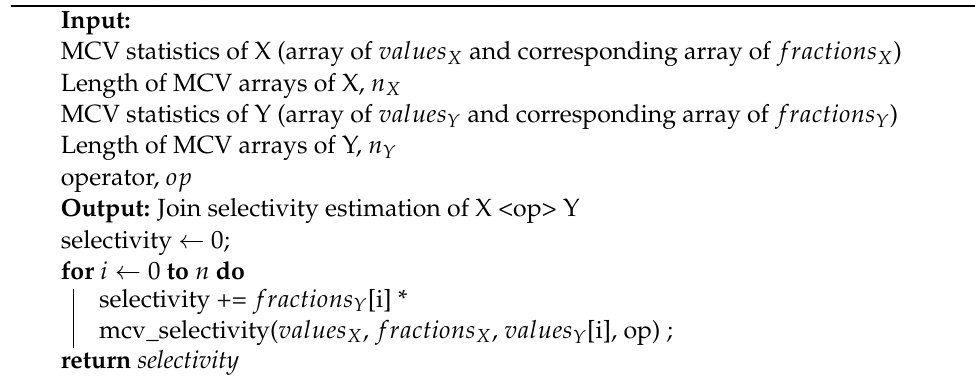
Algorithm 4: Join selectivity estimation algorithm for any binary Boolean opera- tor re-using Algorithm 3 as mcv_selectivity(values, fractions, n , op ).